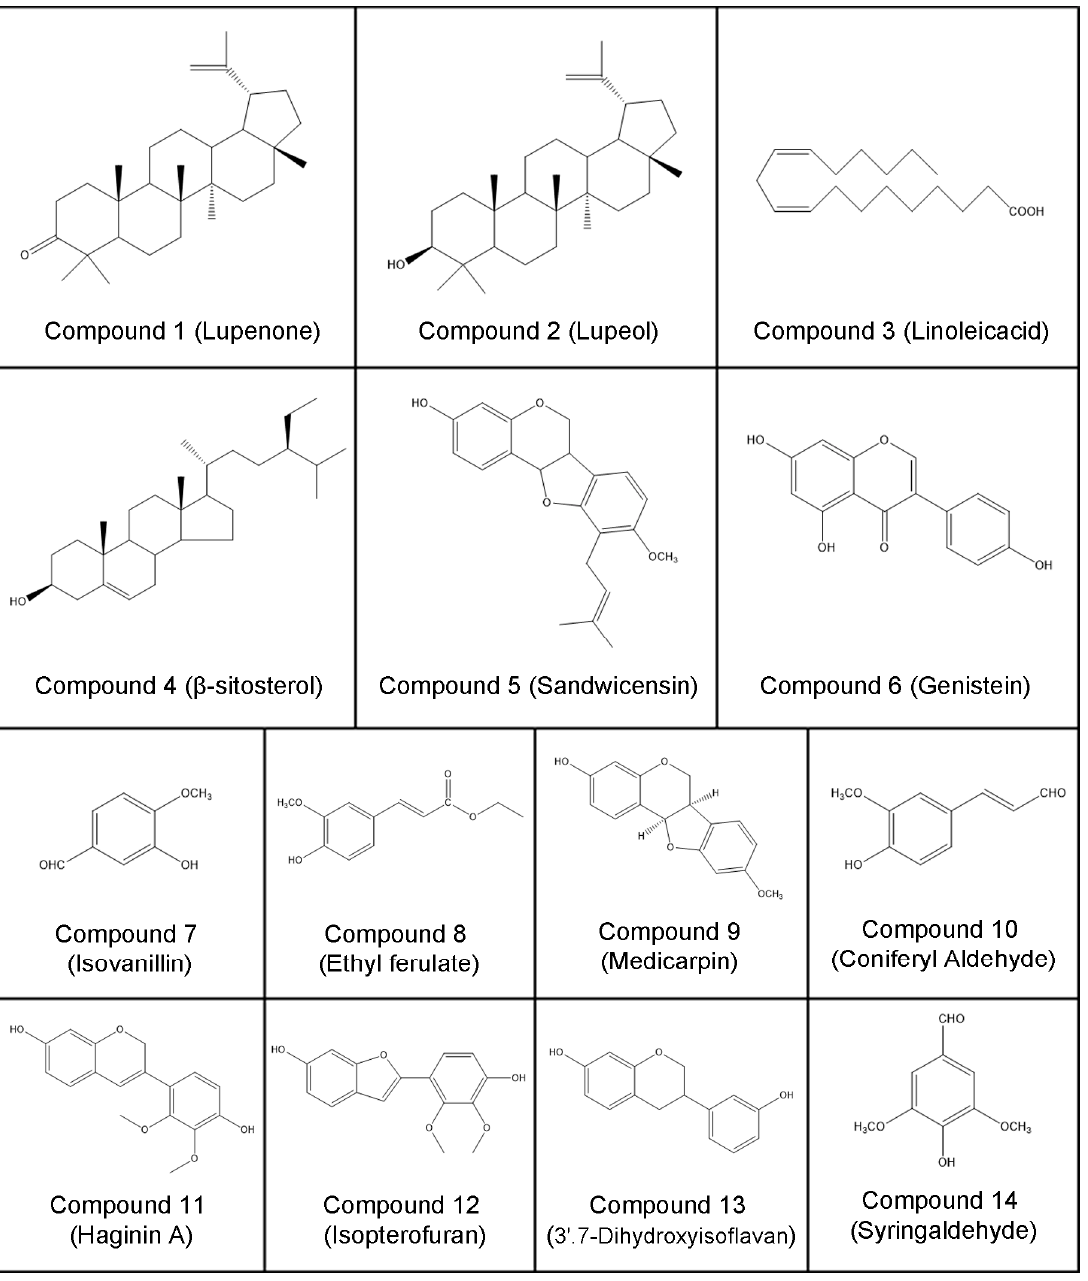
Figure 2. Structure of compounds 1 – 14